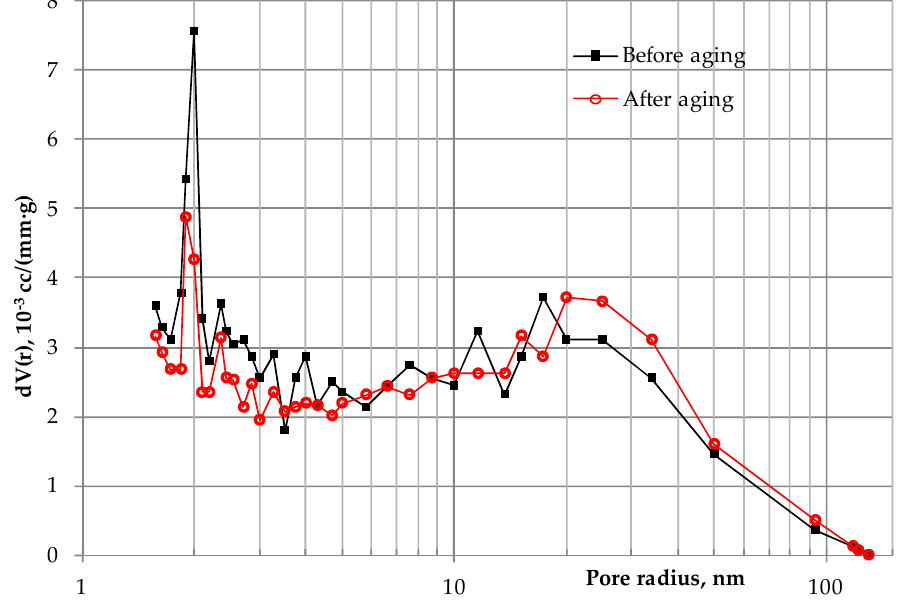
Figure 8. Pore size distribution of hollow fibers before and after aging.